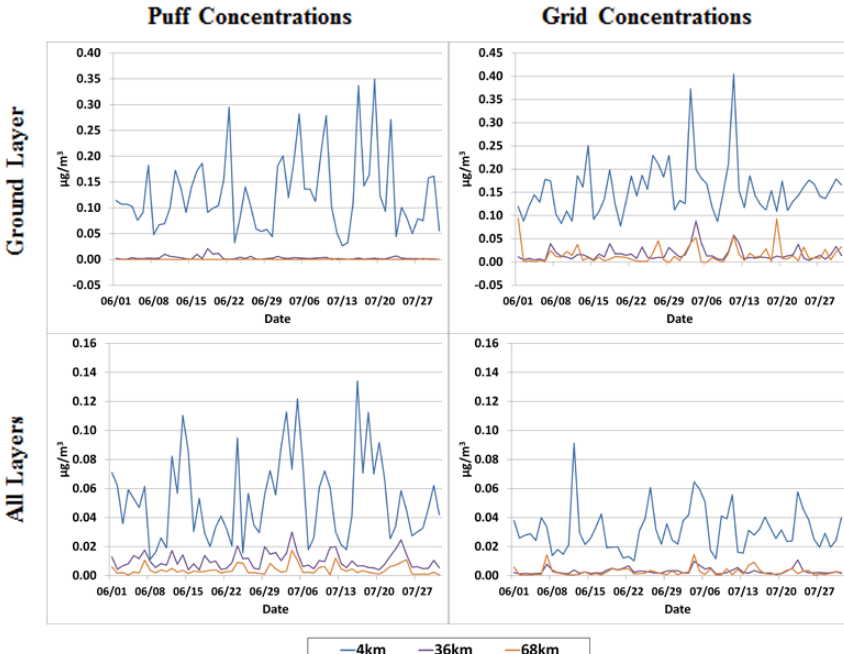
Fig. 8. Median hourly PM 2 . 5 concentrations for each day in puffs and in airport contribution to grid cells at various distances in modeled surface layer, and in all layers, during June and July 2002. The analysis includes only those grid cells in the outermost ring as we go outward from the airport, and thus no overlap of grid cells in each bar. Note that the vertical axis scale varies by